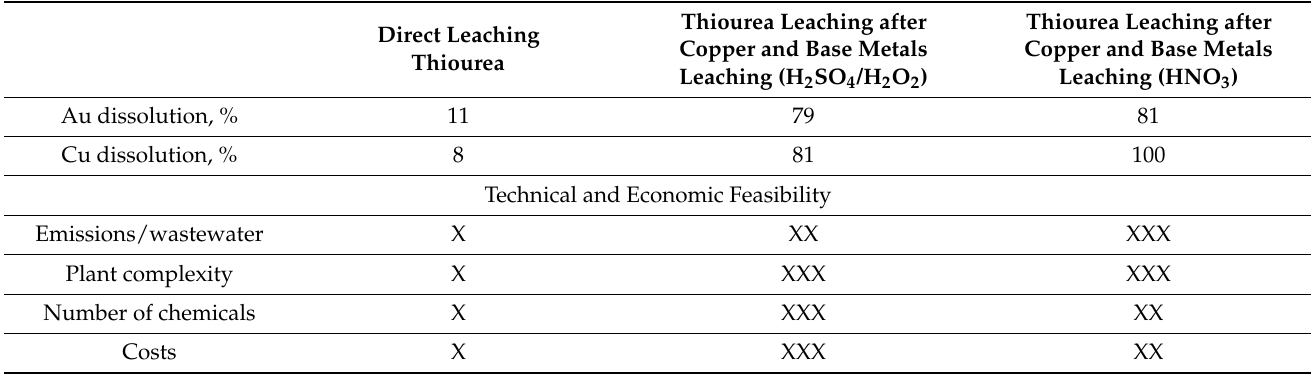
Table 9. Technical and economic feasibility of the investigated treatments as a function of the recovery of metals (X: low impact; XX: medium impact; XXX: high